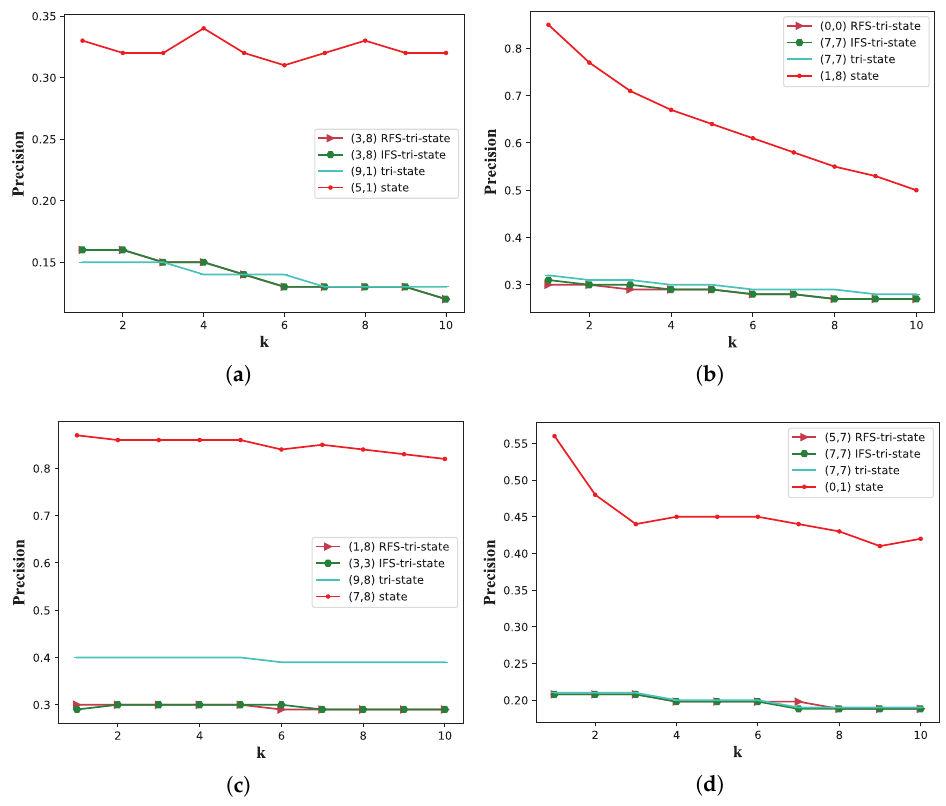
Figure 4. The precisions of four state prediction strategies. ( a ) Dataset I. ( b ) Dataset II. ( c ) Dataset III. ( d ) Dataset